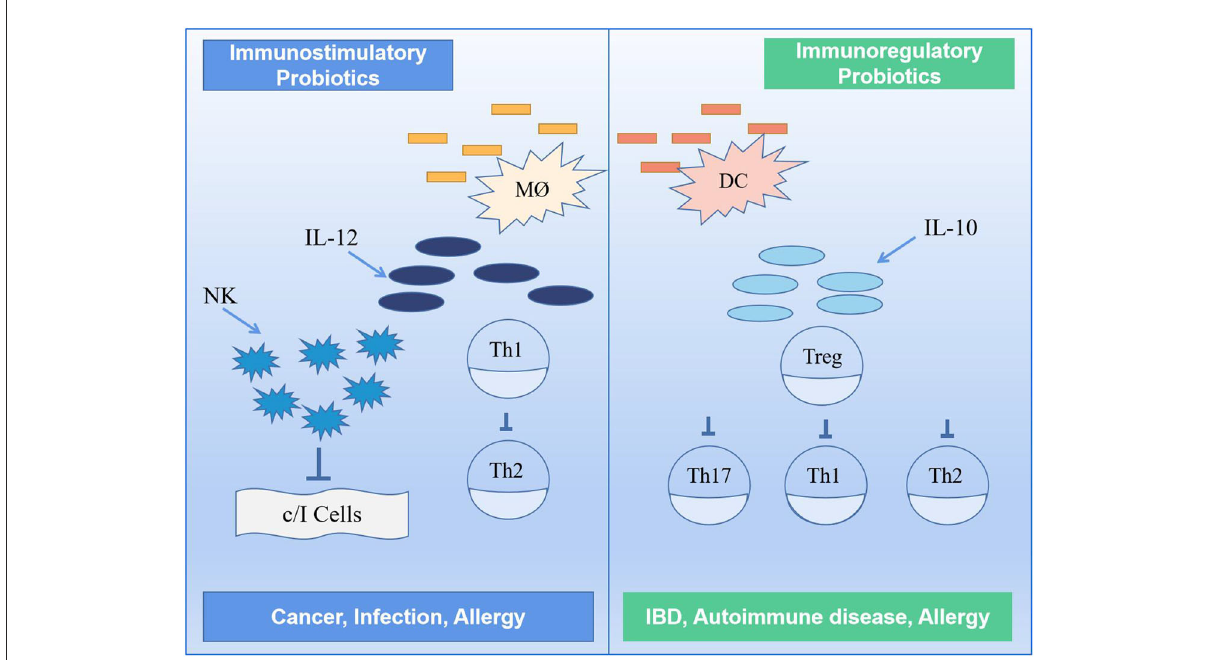
FIGURE7 Mechanism of immune regulation by probiotics (117). TH1, TH2, TH16, type 1T helper, type 2T helper, type 17T helper; DC, dendritic cell; MØ, M cell; IL-10, IL-12, interleukin-10, interleukin-12; NK, natural killer.